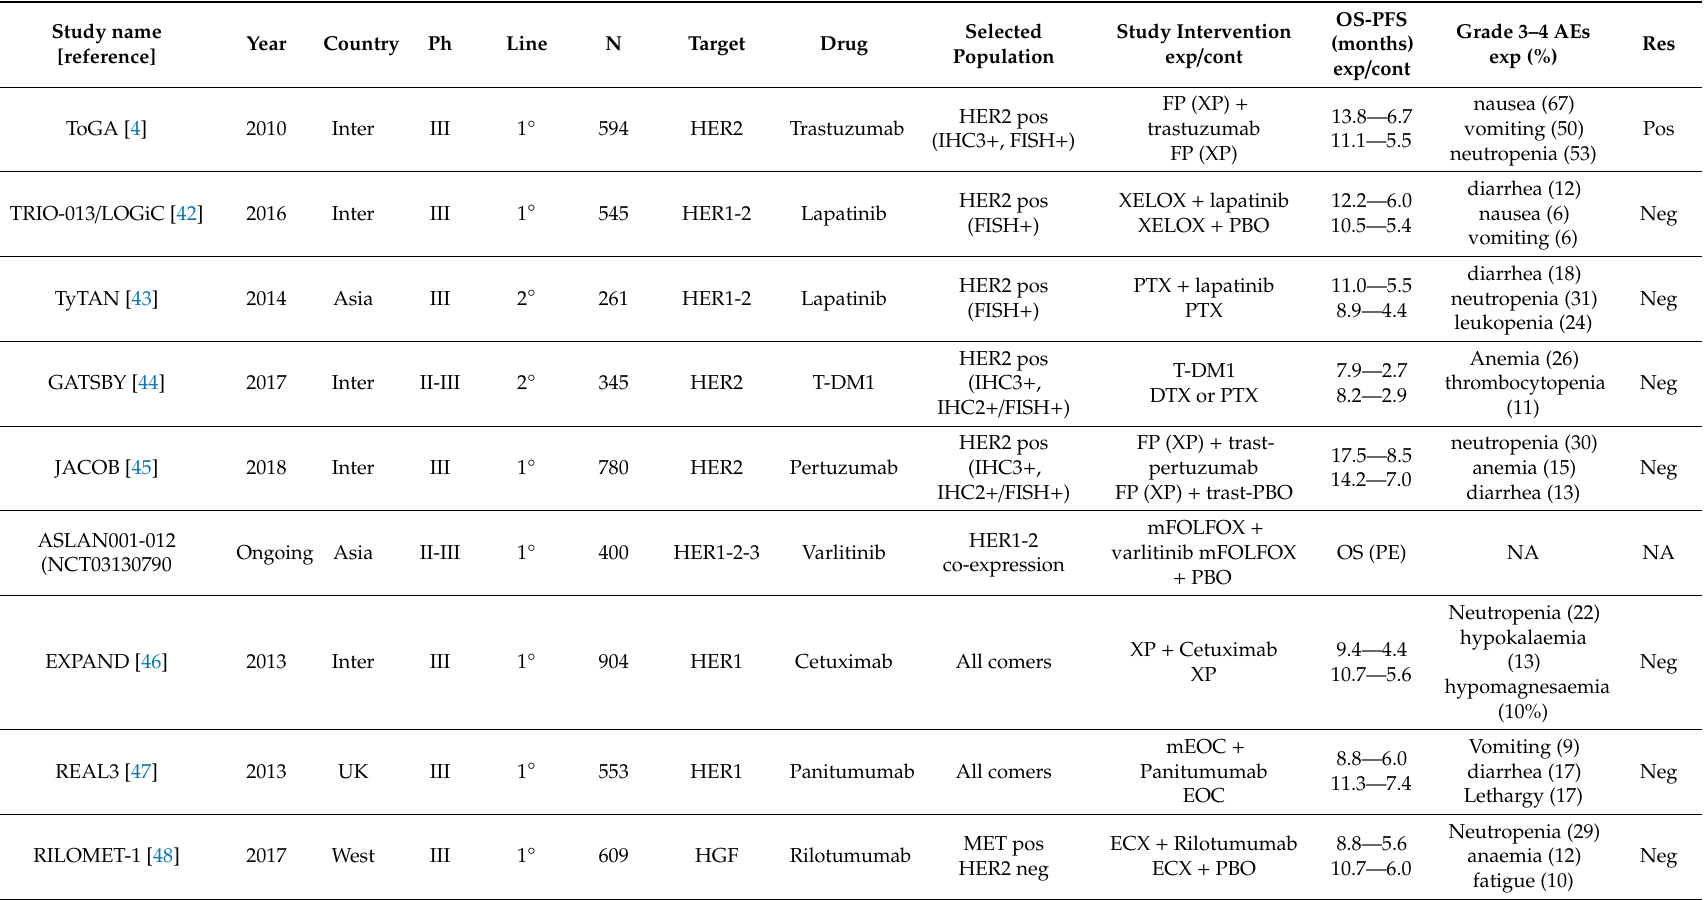
Table 1. List of completed / ongoing phase III or II / III trials with targeted agents in metastatic gastric